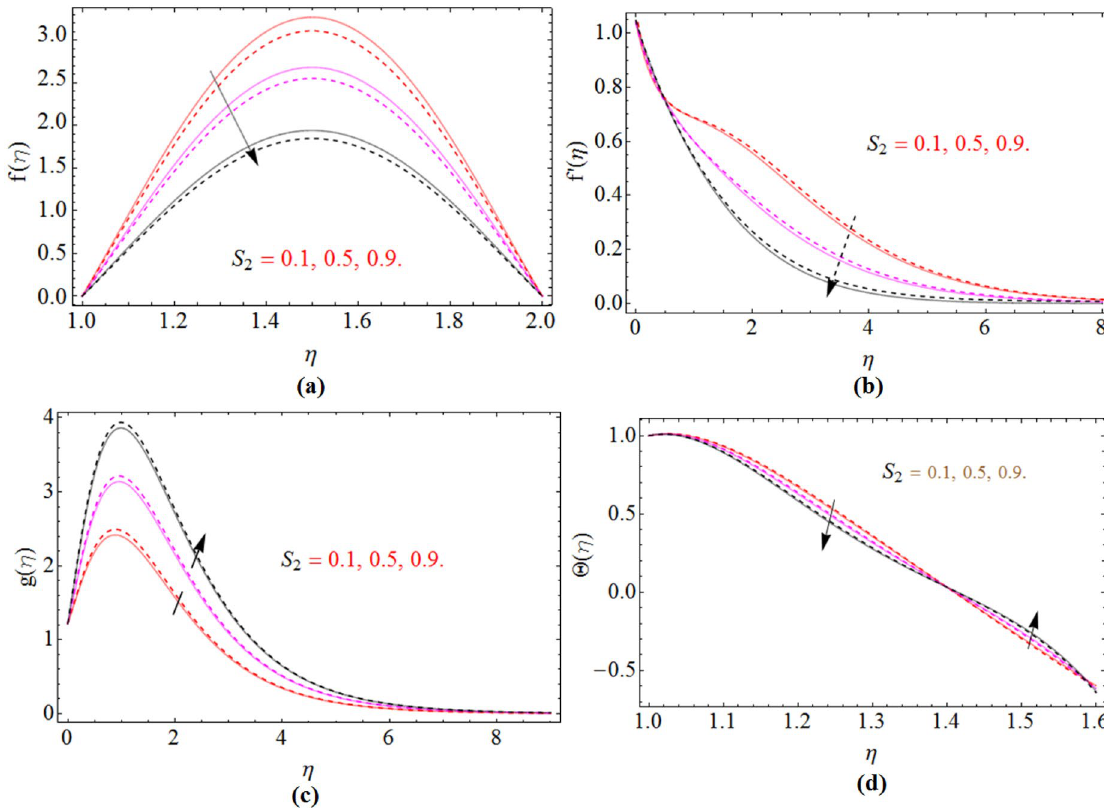
Figure 6. S 2 impact on axial f (η) , radial f ′ (η) and azimuthal velocity g (η) and temperature profile �(η) , for S 2 , when S 1 = 0.5. dashed lines for (cid:31) = 0.5 and lines for (cid:31) = −